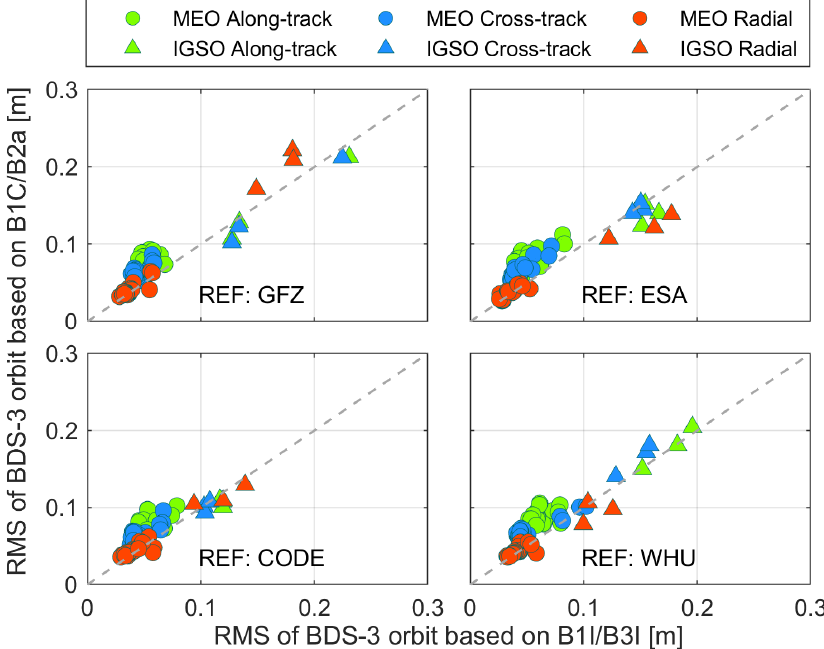
Figure 4. RMS of BDS-3 ISC orbits based on B1I/B3I and B1C/B2a compared with different MGEX ACs in the along-track (A), cross-track (C), and radial (R) directions, respectively.